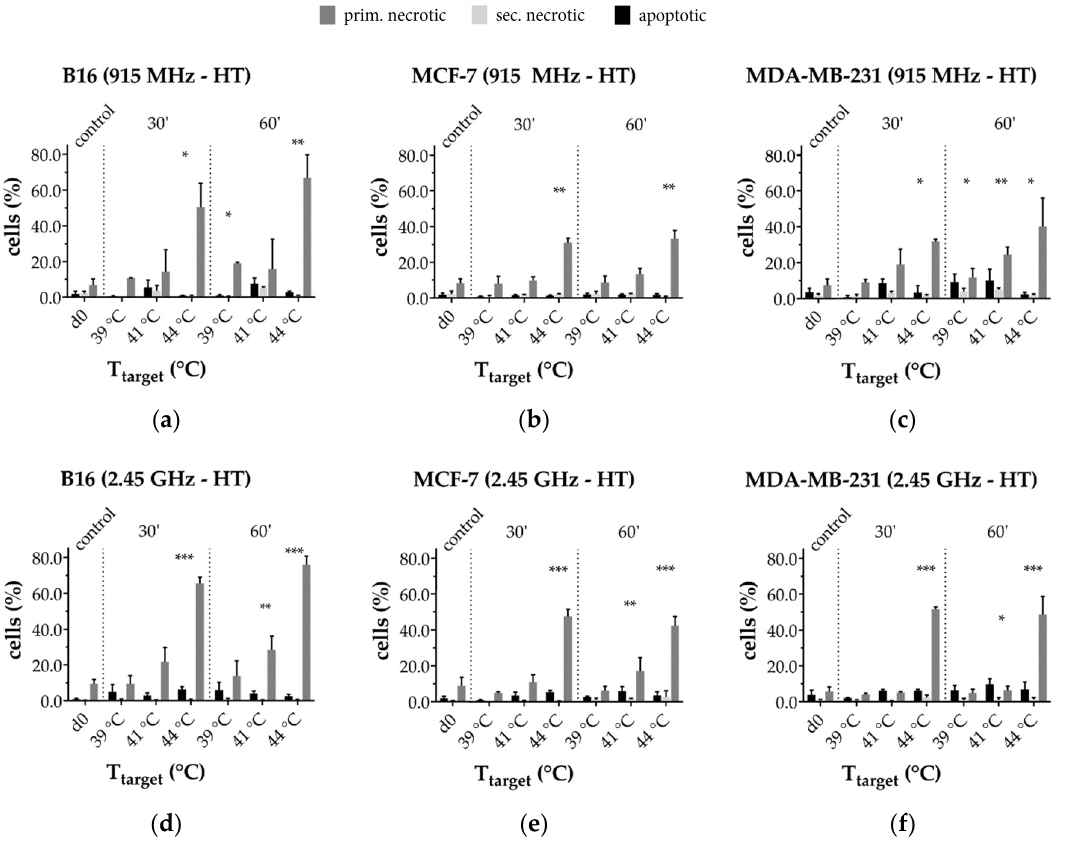
Figure 8. Cell death forms of hyperthermia (HT)-treated cells at 915 MHz (top row) or at 2.45 GHz (bottom row); ( a , d ) murine B16 melanoma; ( b , e ) human MCF-7 and ( c , f ) MDA-MB-231 breast cancer cells. The total percentage of dead cells yields the tumor cell killing efficiency. Mean ± S.D. are presented from at least three independent experiments, each measured in duplicates. Significance was conducted using Kruskal-Wallis test with Dunn’s correction multiple comparison, by comparing treatment related total percentage of inactivated cells to the corresponding control of mock-treated cells at the indicated time point (d0); * ( p < 0.1), ** ( p < 0.01), *** ( p < 0.001).